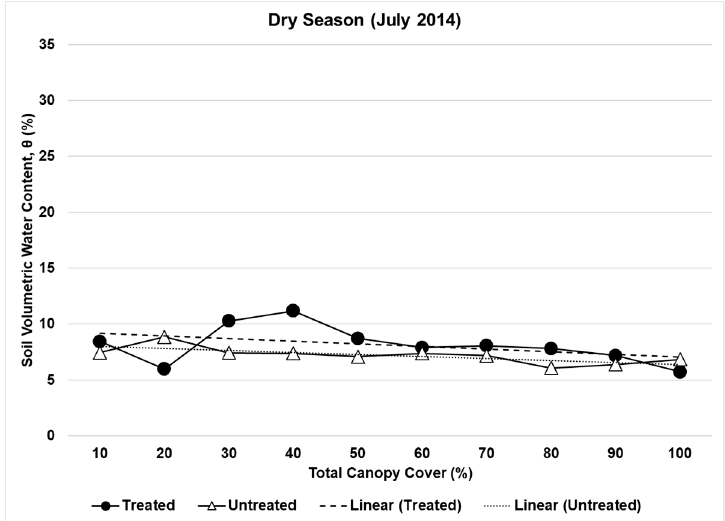
Figure 6. Mean θ (± SE) relative to total canopy cover (%) for the month of July 2014 (dry season) in both watersheds. Mean θ was estimated based on θ records from 142 transects in the treated watershed and from 140 transects in the untreated.